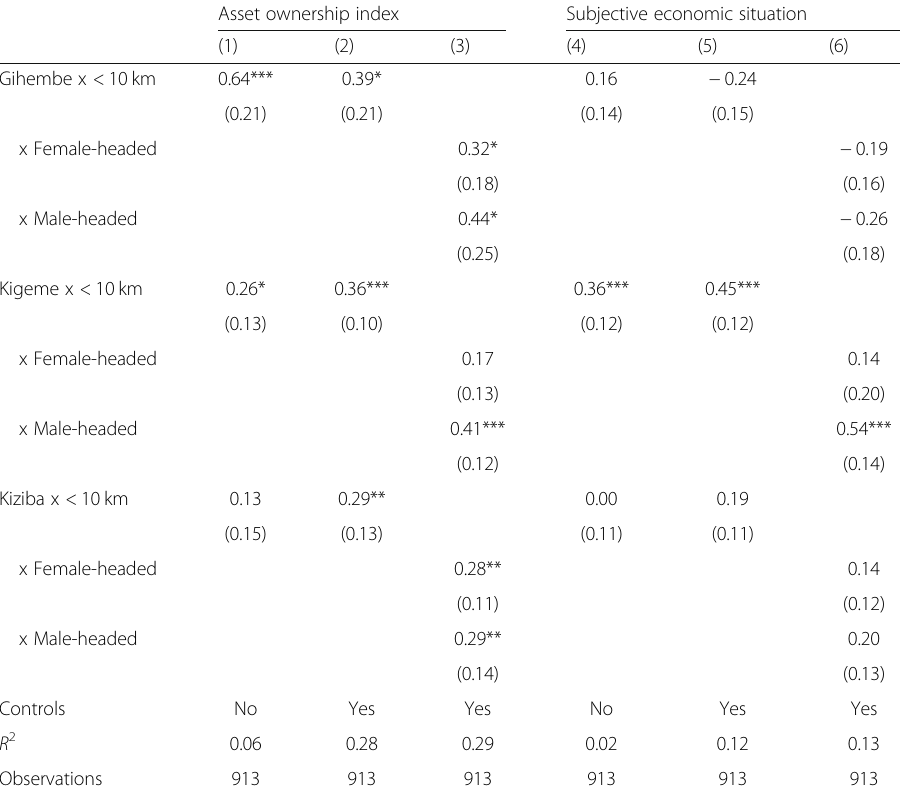
Table 11 Economic welfare, by camp area Asset ownership